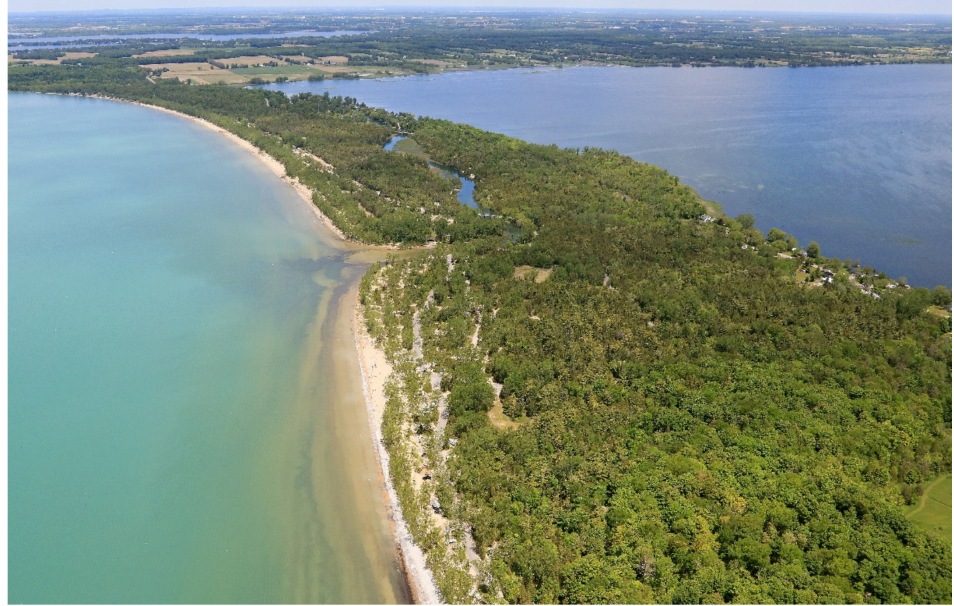
Figure 12. The high water level in East Lake, Outlet River, and Lake Ontario (Aerial image by: John A. Brebner, 2019 © 2019 Friends of Sandbanks